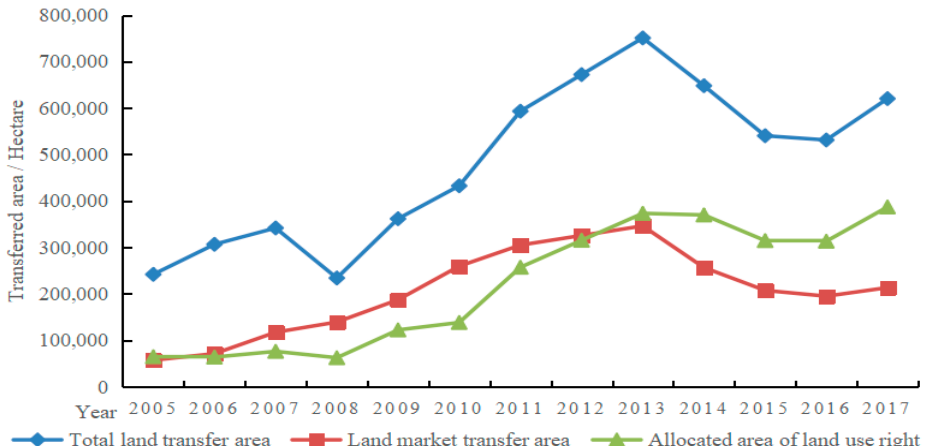
Figure 2. China’s state-owned land transfer category and area from 2005 to 2017.